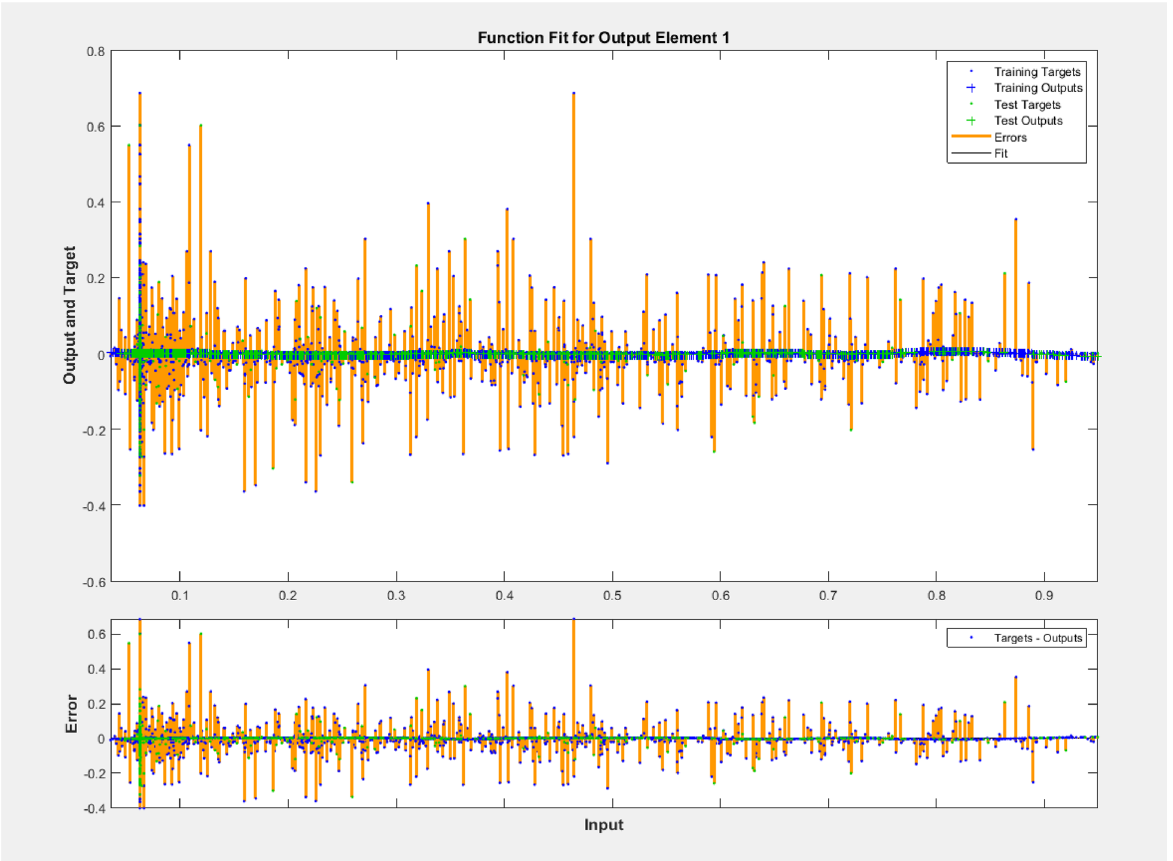
Fig. 11 Correlation analysis of input image vs. output